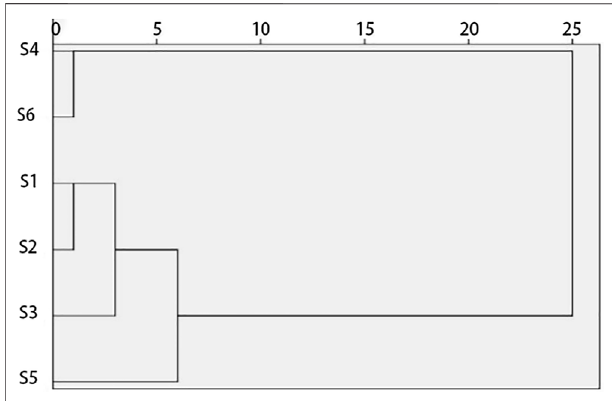
FIGURE 5 | Cluster diagram of six